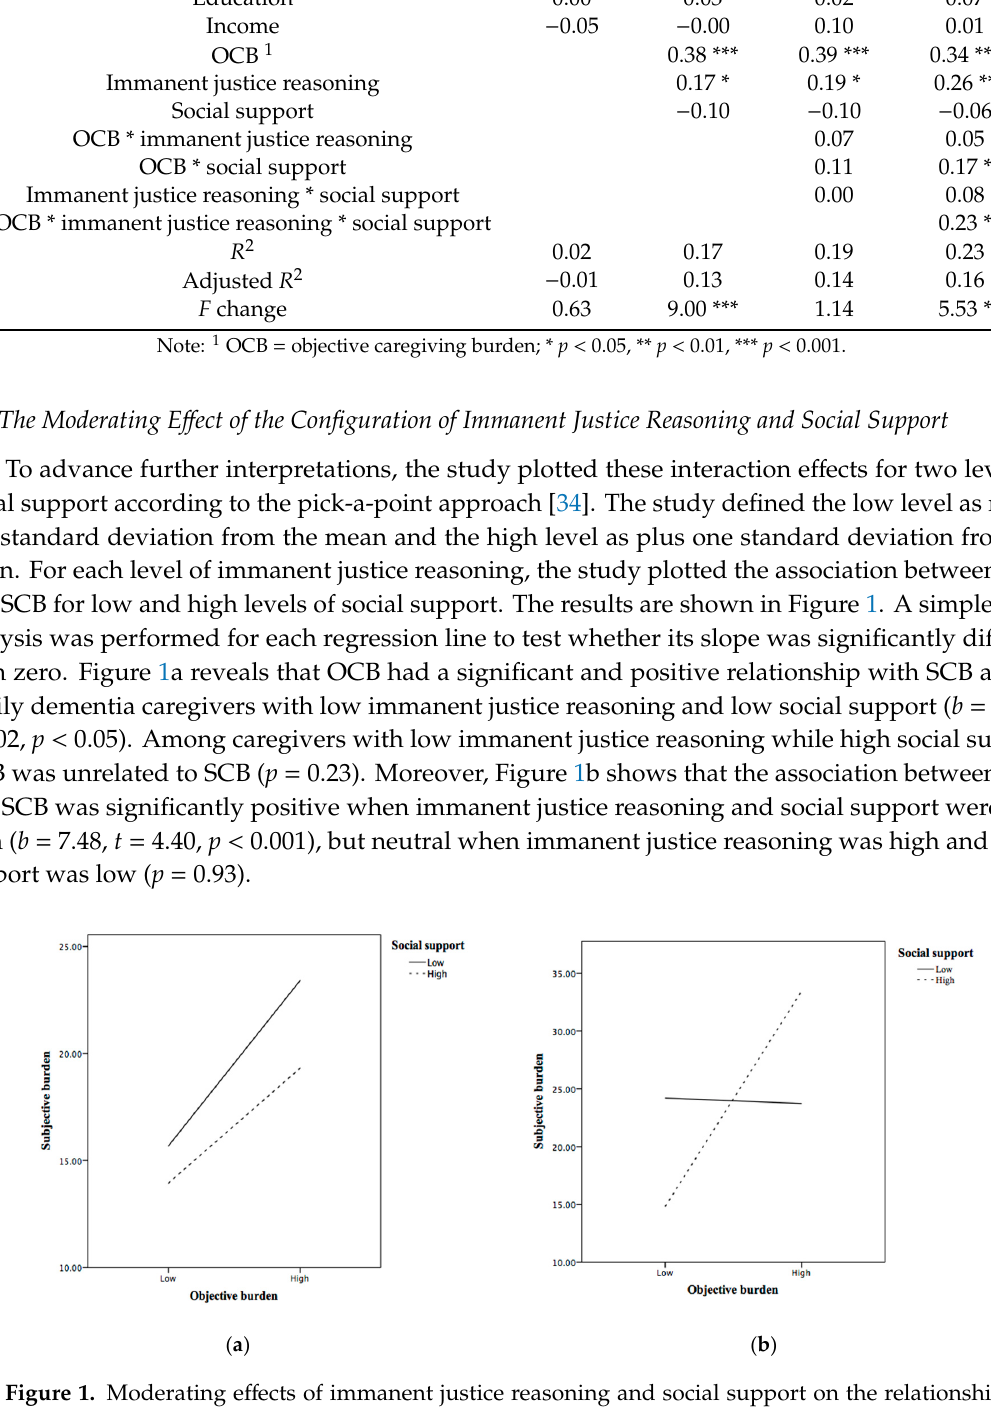
Figure 1. Moderating effects of immanent justice reasoning and social support on the relationship between objective and objective caregiving burden. ( a ) Low immanent justice reasoning; ( b ) High immanent justice reasoning.